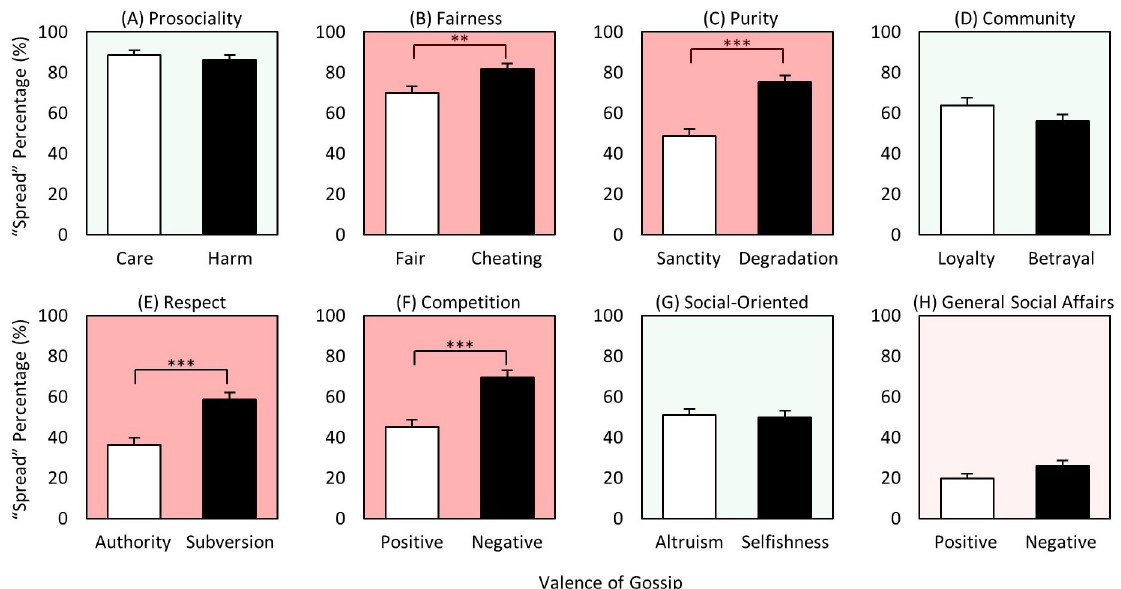
Fig 12. Mean gossip spread rates about celebrity targets for positive versus negative events. The graphs with red shade ((B), (C), (E) & (F)) are those with higher positive spreading rates than negative spreading rates. The graph with pale red (H) is not statistically significant yet has the trend of the graphs with its corresponding color. The graphs with pale green ((A) & (G)) are not statistically significant yet show the opposite trend of the graphs with red shade. � p < 0.05, �� p < 0.01, ��� p < 0.001.